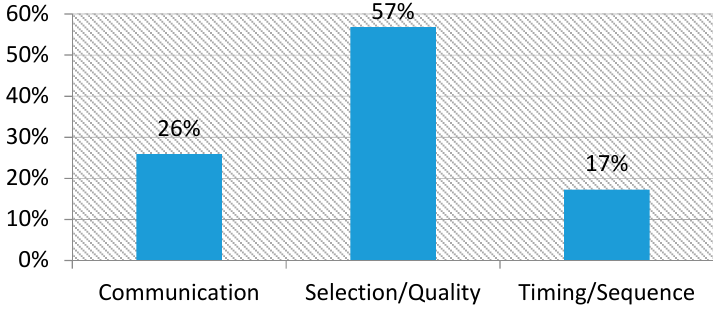
Figure 8. Percentages for the External Error Mode.